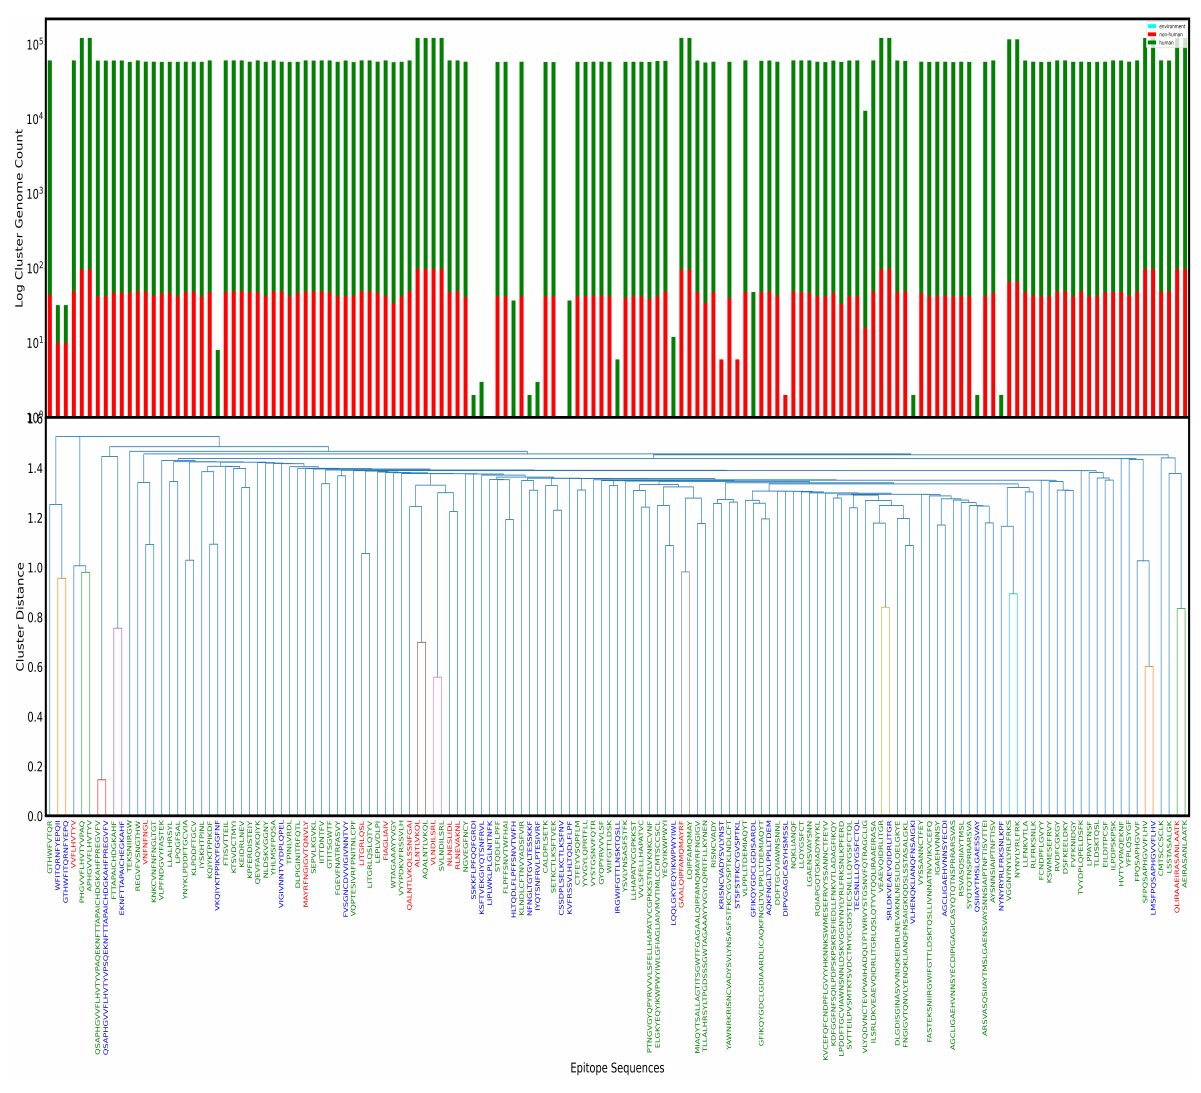
Figure 1. Clustering of Spike glycoprotein T cell Epitopes ORIGINAL + CANDIDATE and their occurrence. The bottom chart is a dendrogram obtained by performing sequence based clustering on T cell S epitopes. The labels along the x-axis in the dendrogram are the epitope sequences and have been assigned colors based on their originating organism: blue if CANDIDATE epitope, red if originally found in SARS, and green if known to be found in SARS-CoV-2. Along the y-axis of the dendrogram is the edit distance score. The edit distance of two sequences lets us know how similar the sequences are to one another. We put a threshold of 1.0 on this edit distance to discover clusters within the epitopes, i.e., epitopes with normalized distance < 1.0 are part of same cluster. In the top part of each figure, the bars align with the epitope labels from the dendrogram. Each bar represents the number of times all members of the cluster to which the epitope belongs are seen across SARS-CoV-2 genomes in our dataset. It is also important to note that the figure is actually a log–log plot of the counts. Furthermore, each bar is stacked based to show genomes sequenced in humans, animals, or environment. We would also like to highlight that low presence in genomes sequenced from environment is not a consequence of epitopes not being found in those genomes, but rather a product of extremely low numbers of high quality genomes from the environment in our